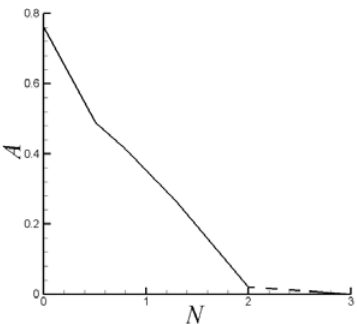
Figure 15. Limiting amplitude of oscillating cylinder displacement after control versus the interaction parameter N for 0.2 K = .